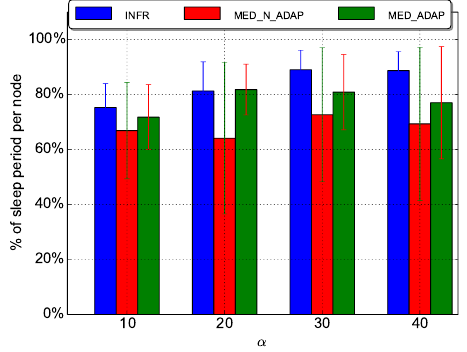
Figure 10. Average duty cycle per node.